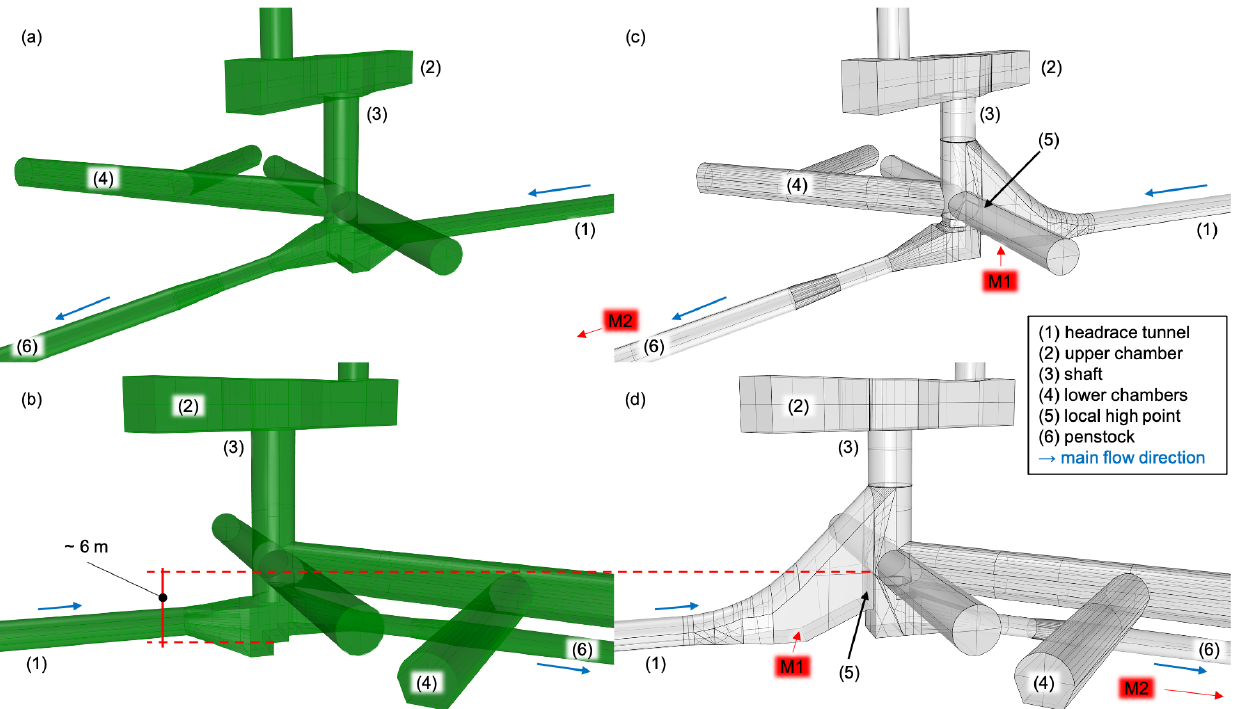
Figure 4. Comparison of the original geometry of the surge tank in green ( a , b ) with the new approach including the wall and extra excavation ( c , d )—normal flow direction under steady operation marked with blue arrows— M 1 indicates the filling pipe which was used as an upstream measurement point and M 2 marks the downstream measurement